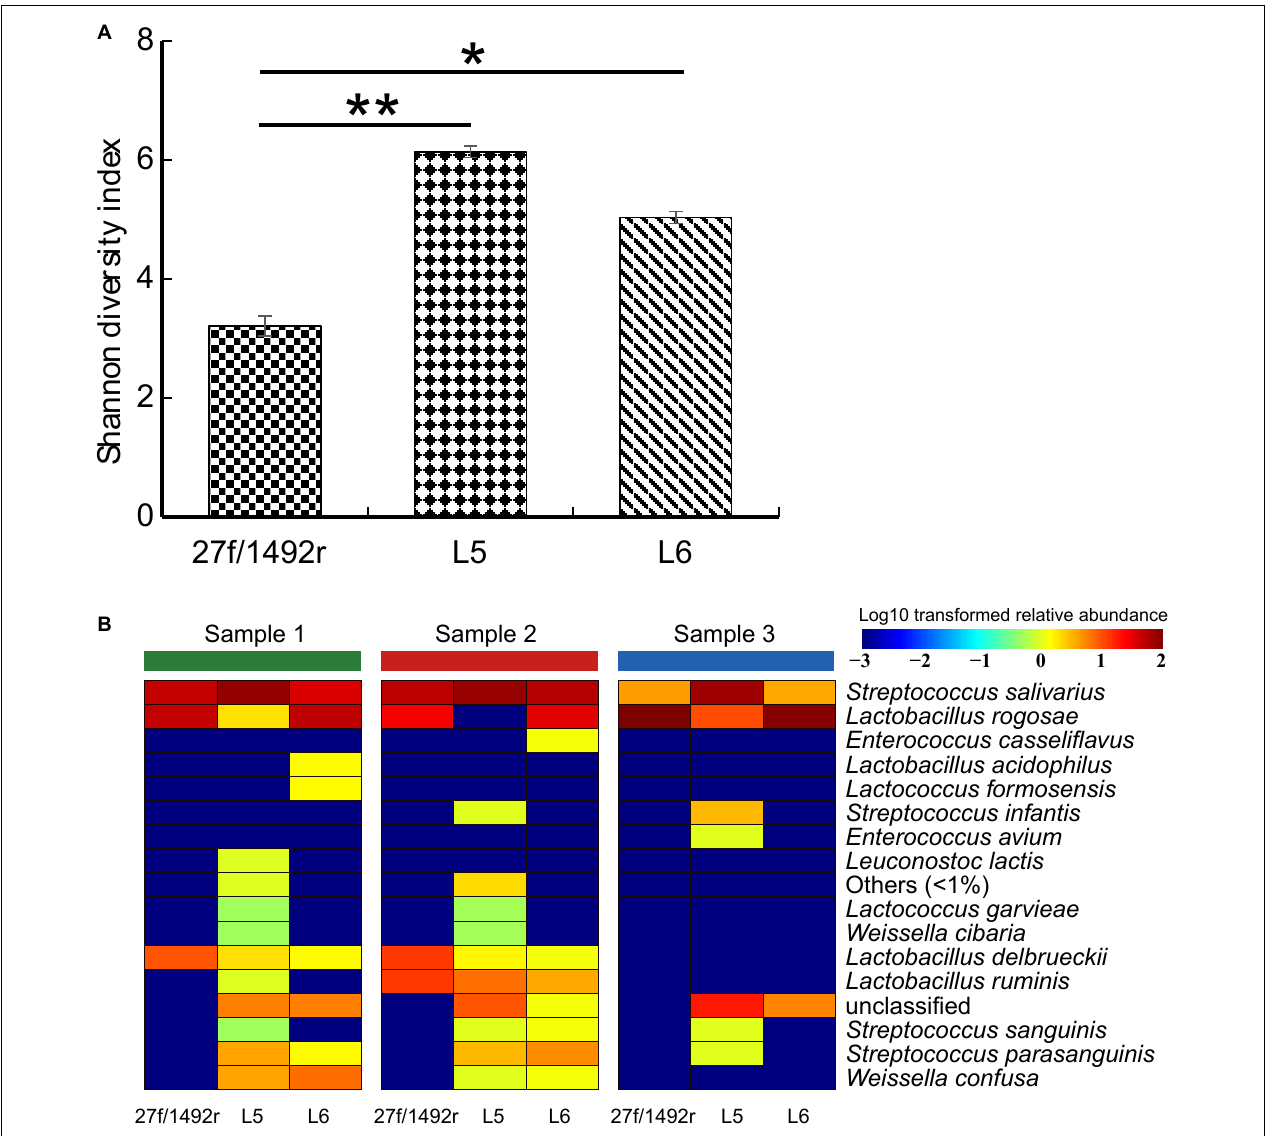
FIGURE 4 | (A) Shannon diversity index and (B) diversity of target LAB OTUs in three fecal DNA samples amplified using candidate LAB-specific primers. (A) All target LAB OTUs were extracted from the sequence data, the Shannon diversity index was calculated, a histogram was created and significant differences were tested. (B) All target LAB OTUs were annotated (QIIME ver. 7.0) and a heatmap was created according to the presence and relative abundance of the target bacteria at the species level. Significant difference at ∗ p < 0.05 and ∗∗ p <